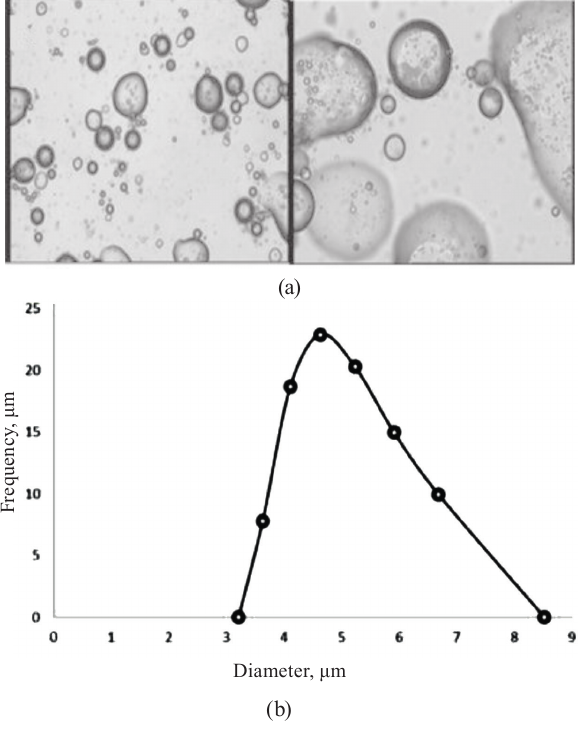
Figure 2 (a) Optical microscopy of EGCE (100×, 400×) and (b) Droplet size distribution in